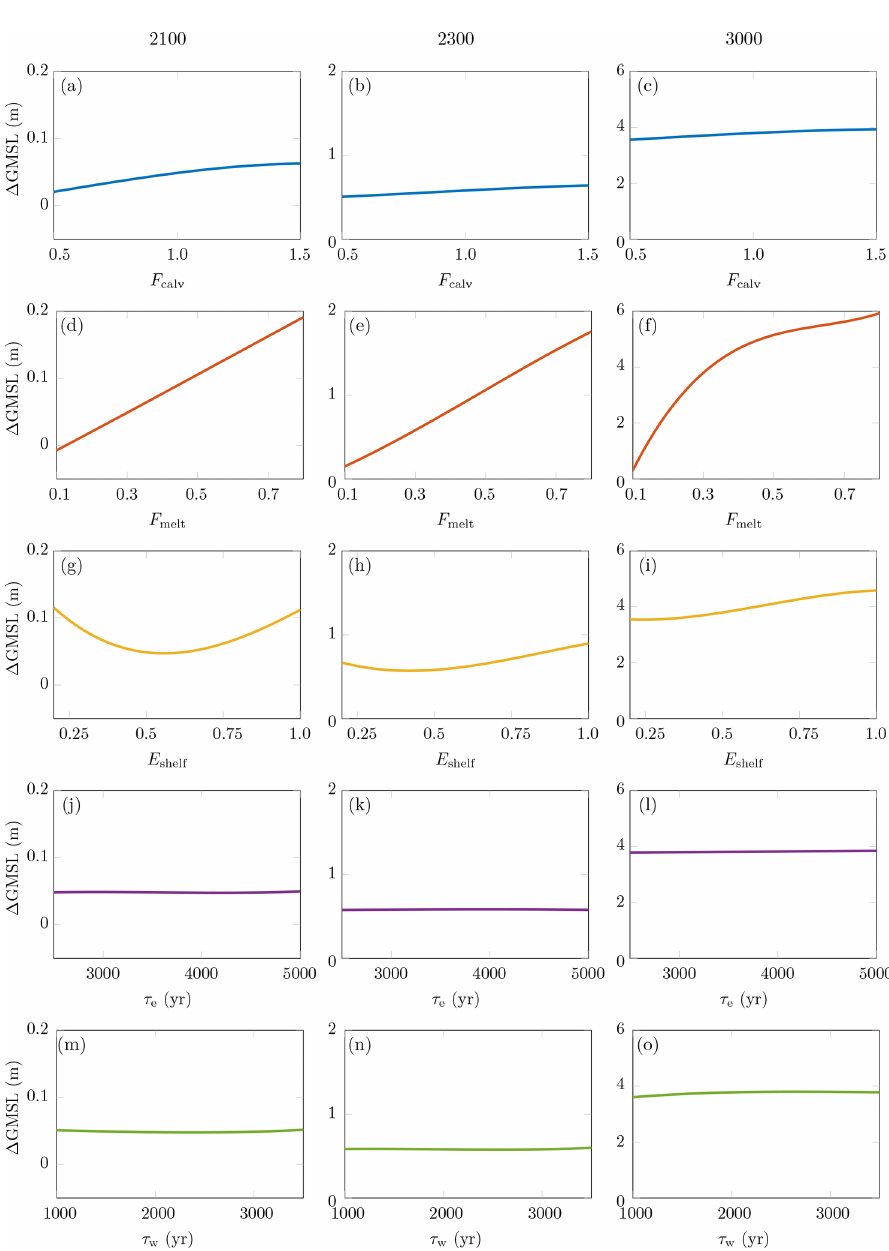
relative dispersion in (cid:49) GMSL via the coefficients of vari- ation, that is, the ratio between the standard deviation and the mean value, we find a coefficient of variation of 0.74 in 8.5 by 3000 under the weakly non-linear sliding law. This demonstrates that the relative uncertainty in (cid:49) GSLM pro- jections is higher in cooler RCP scenarios. This results from a much larger increase in the values of (cid:49) GSLM projections compared to the increase in their dispersion when the RCP scenario gets